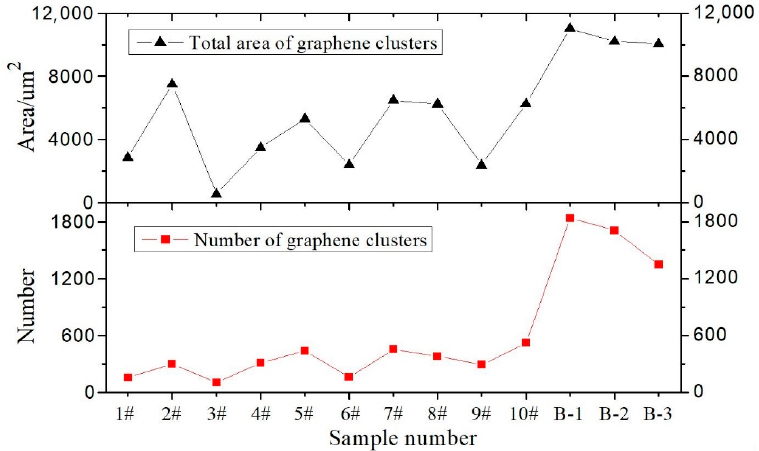
Figure 8. Variation trend of graphene cluster total area and quantity.